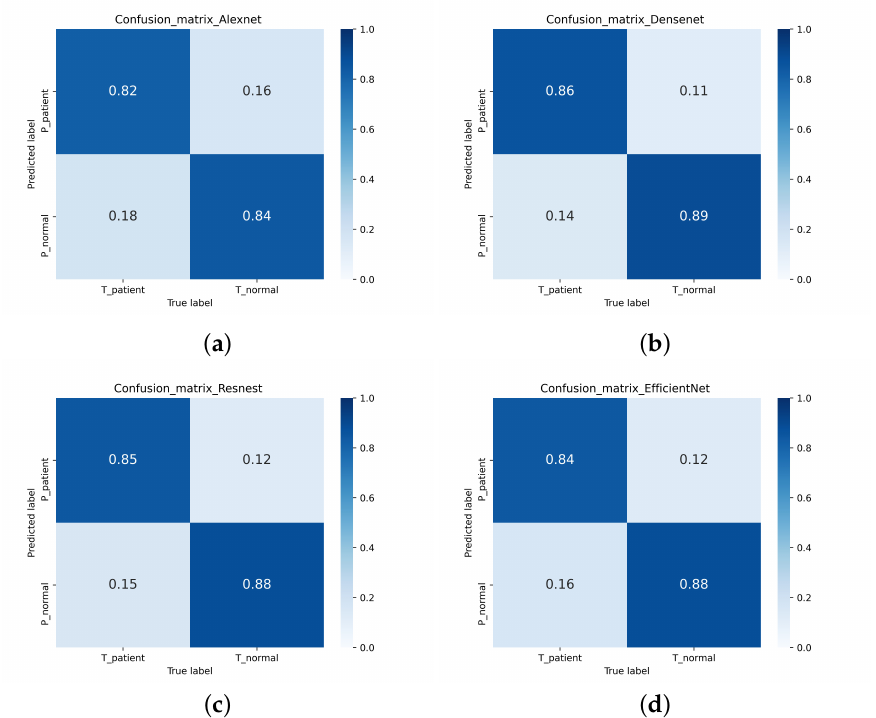
Figure 14. The confusion matrix of the single-mode MRI data set. ( a ) Alexnet ( b ) Densenet ( c ) ResNeSt ( d )